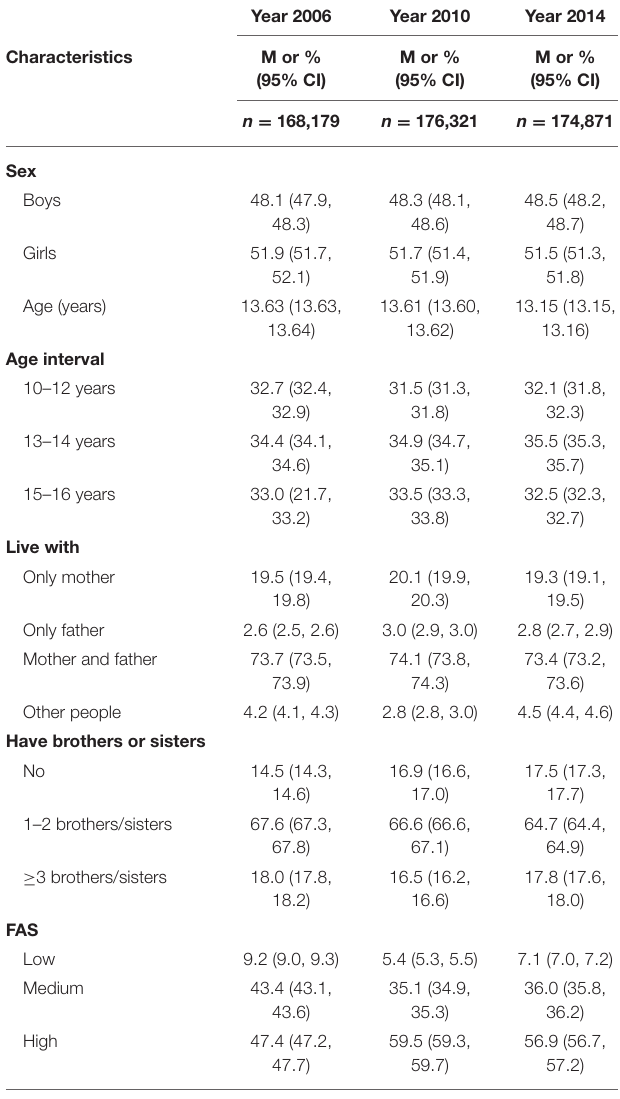
TABLE 1 | Participants’